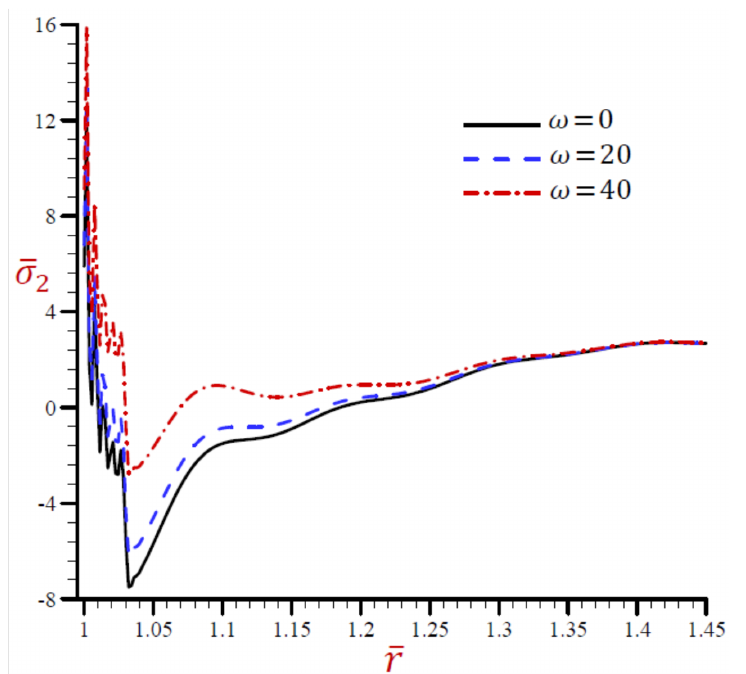
Figure 11. Effect of ω on radial stress σ 2 across the radial direction of the cylindrical cavity utilizing the RDPL